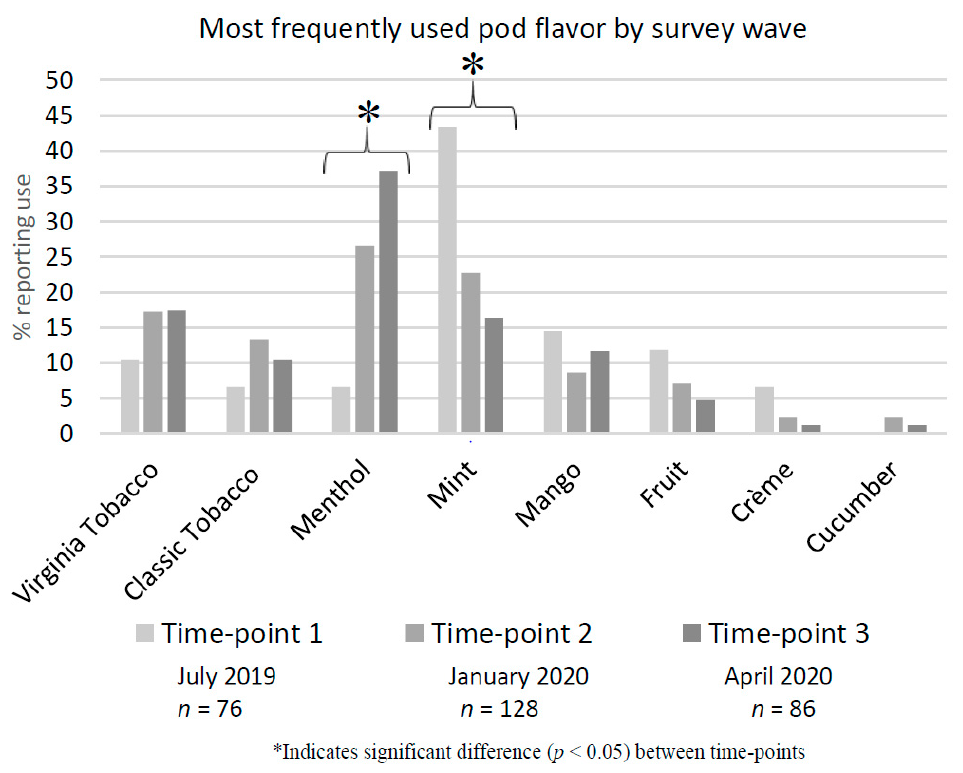
Figure 2. Most frequently used pod flavor by survey time-point.